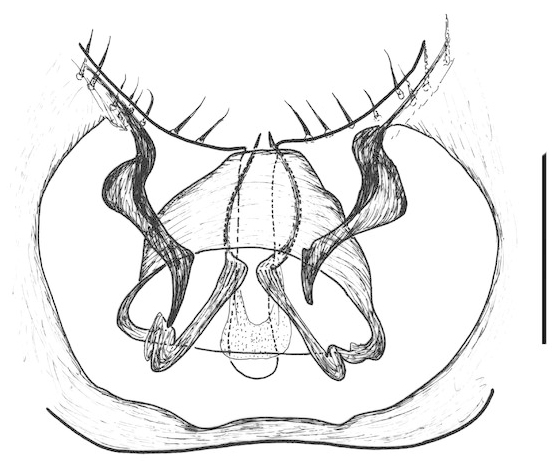
aedeagal complex